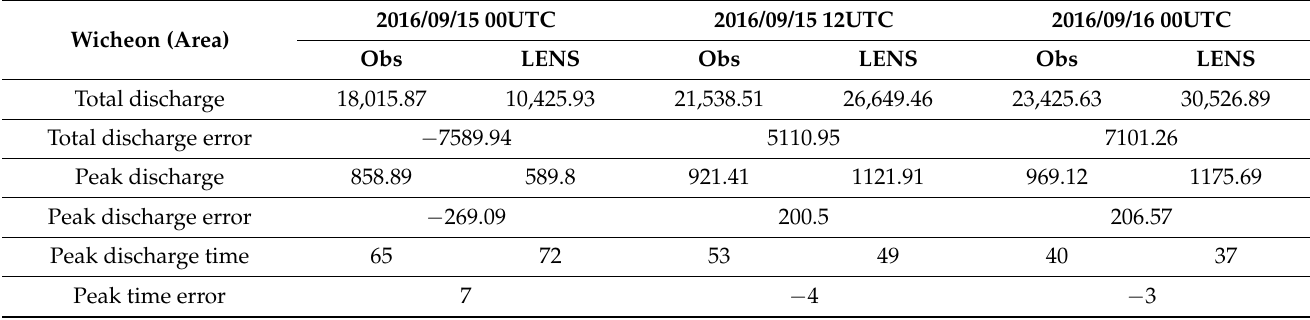
Table 13. LENS area discharge data results from 2016/09/15 00UTC to 2016/09/16 00UTC.